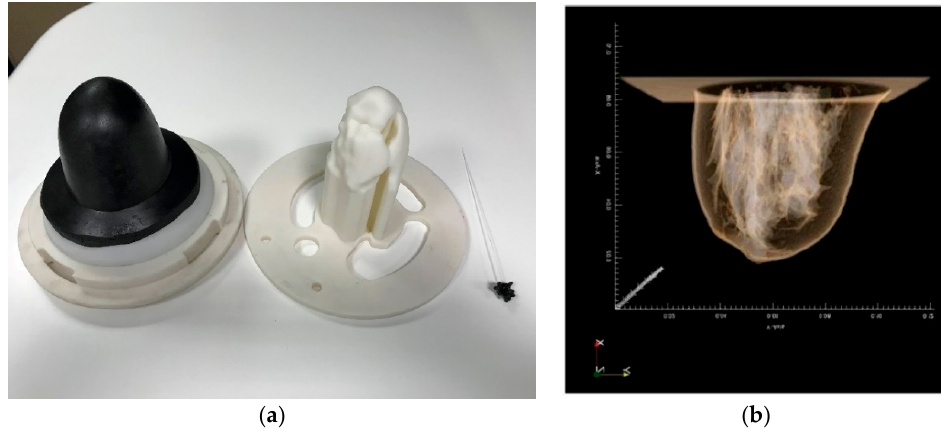
Figure 4. The breast molds: ( a ) Bottom view of the outer breast surface mold (on the left), covered with the black 2-mm thick skin phantom, and the outer fibroglandular tissue mold; ( b ) Original geometry of the breast, segmented from an MRI breast image.